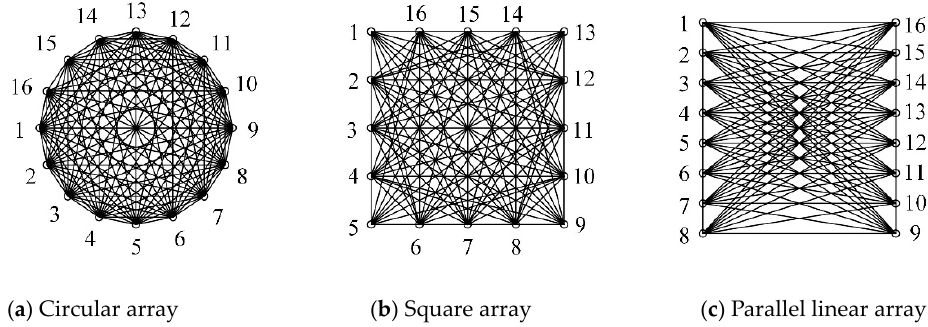
Figure 3. Three patterns of PZT (Lead Zirconate Titanate) sensor array configuration and their sensing paths.